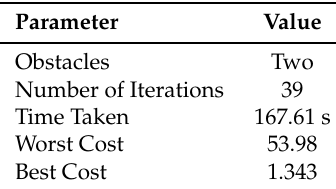
Table 4. Flight C Real Time Trajectory Planner Parameters.